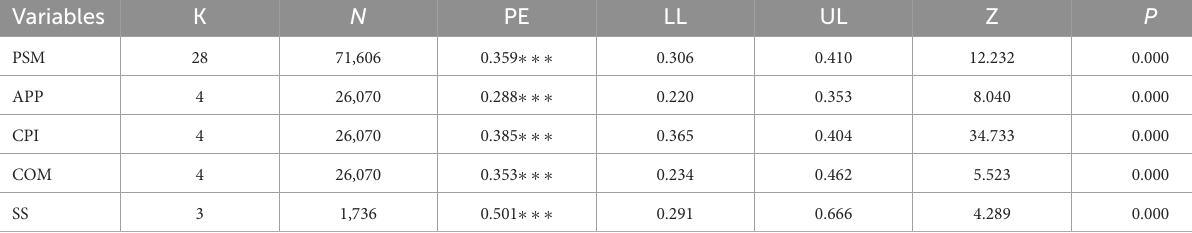
TABLE 3 Main effects test (this table reported the relationship between public service motivation and its subdimensions with work engagement).